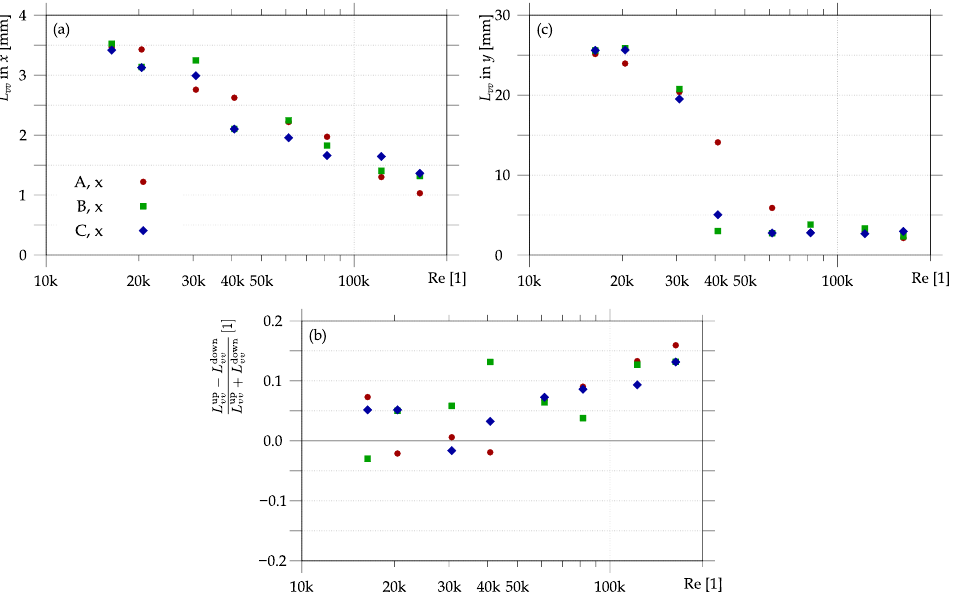
Figure 19. Integral length-scale of cross-stream velocity component v . Panel ( a ) shows the integral length-scale along the stream-wise axis; however, it is different in upstream and downstream direc- tions, and panel ( b ) shows this asymmetry. Panel ( c ) shows the integral length-scale of v along the cross-stream axis. Angle of attack α = 0 ◦ in all